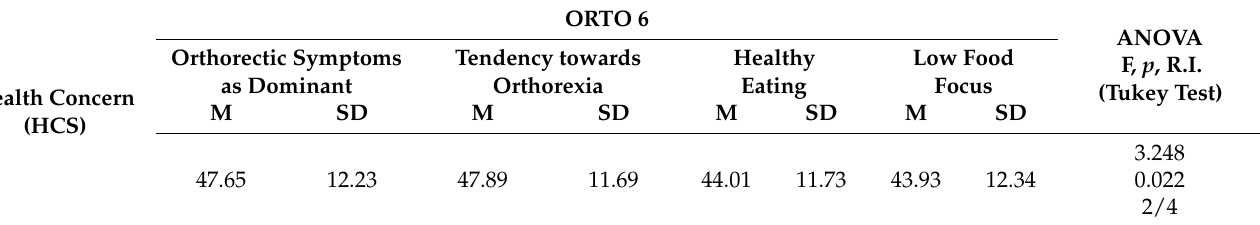
Table 4. Caring for health among all